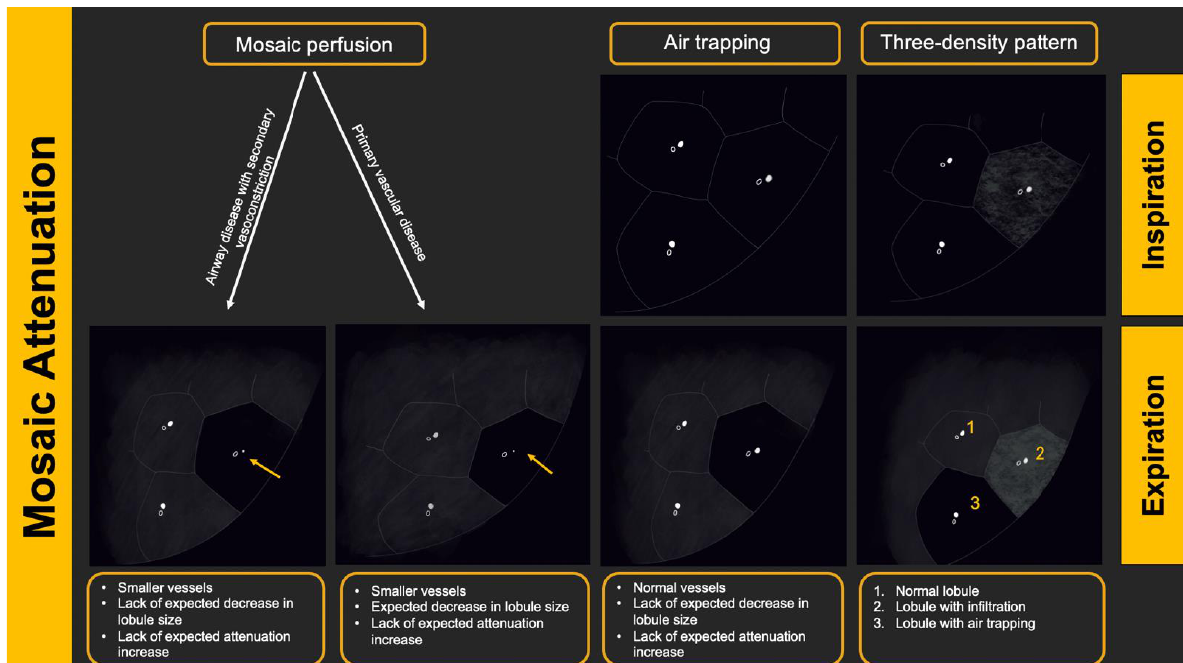
Figure 2. Flow diagram showing the heterogeneous lung attenuation patterns. Mosaic attenuation is a terminology reserved for inspiratory phase imaging and can be seen in vascular diseases, small airway disease or infiltrative diseases such as hypersensitivity pneumonitis. Mosaic perfusion is a feature of primary vascular disease but can also be seen with small airway disease due to hypoxic vasoconstriction.